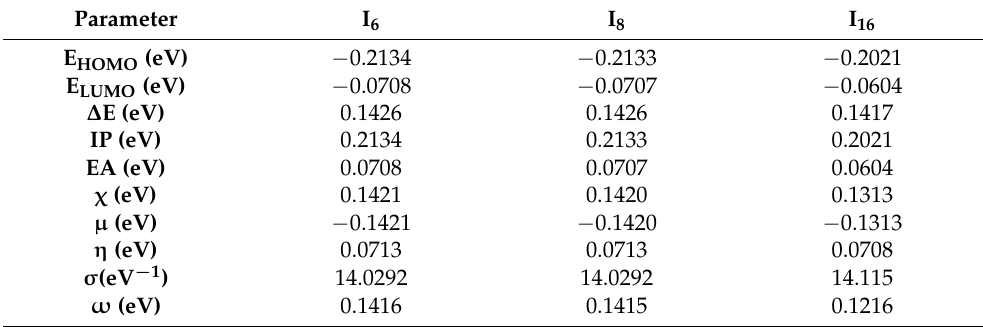
Table 3. Quantum chemical parameters based on optimized structures of the investigated compounds at B3LYP/6-311G(d,p) level of